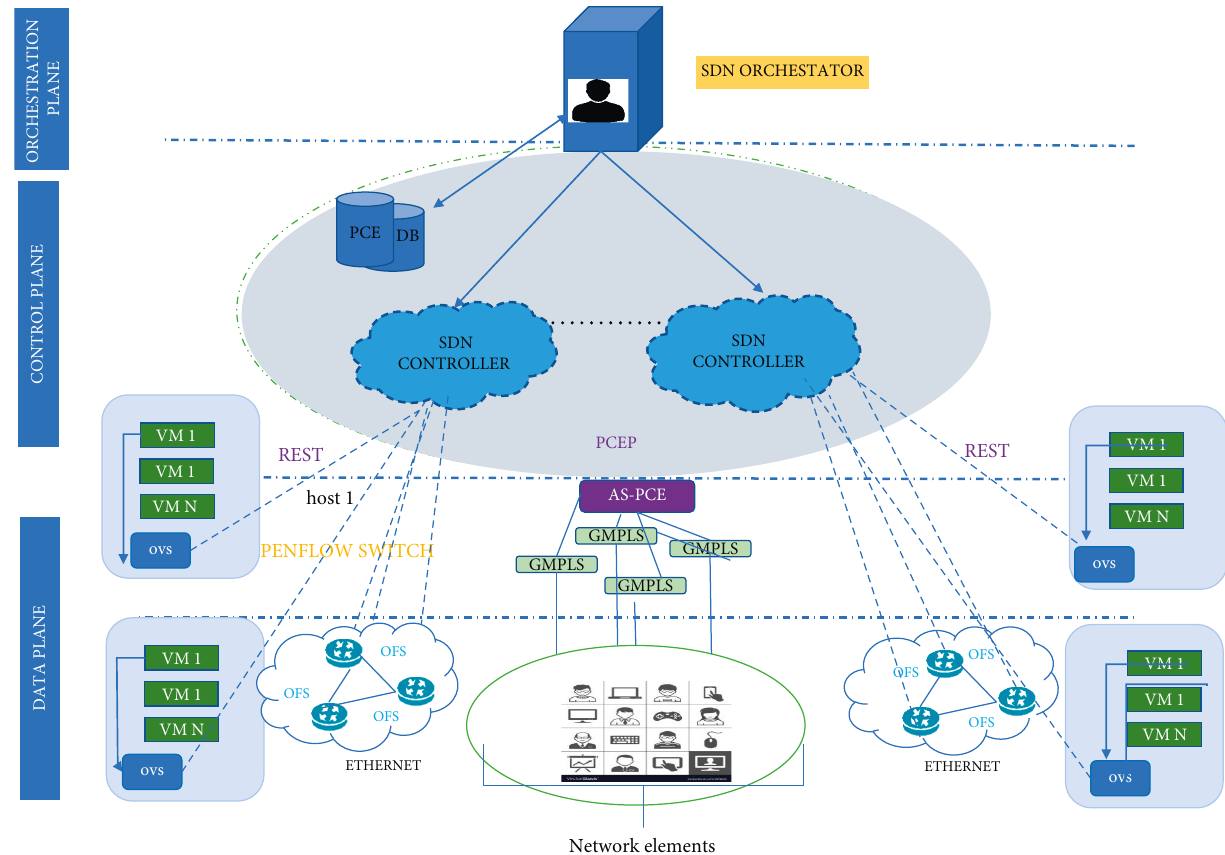
Figure 8: SDN orchestration